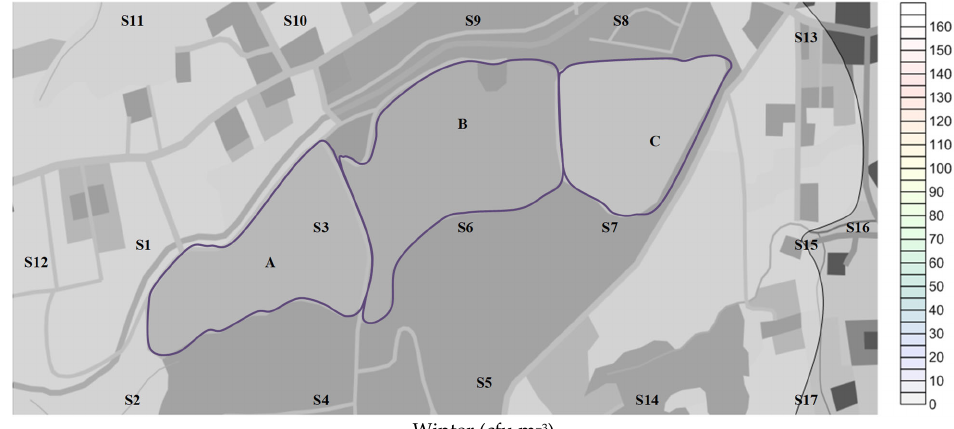
Figure 4. Spatial distribution of Salmonella spp. in the soil collected within the municipal landfill area. The map is the result of the imposition of the isopleth map on the background of the landfill area plan implemented as a graphic to one of the map layers. (A) Active sector, currently exploited; (B,C) inactive, closed, and recultivated sectors. The sites from S4 to S9 were located within the forest zone. The sites S1, S10, S12, S13, S15–S17 were located in farmlands. The sites S2, S11, S14 refer to corresponding meadows.